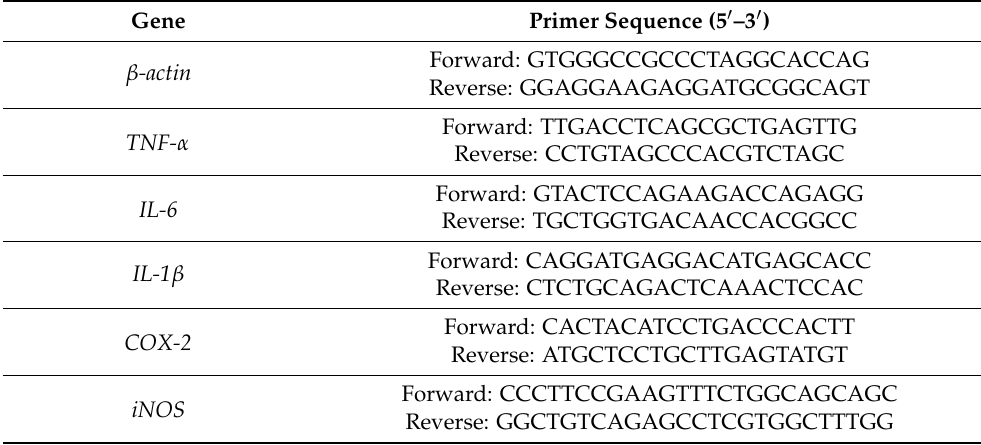
Table 1. Nucleotide sequences of primers.